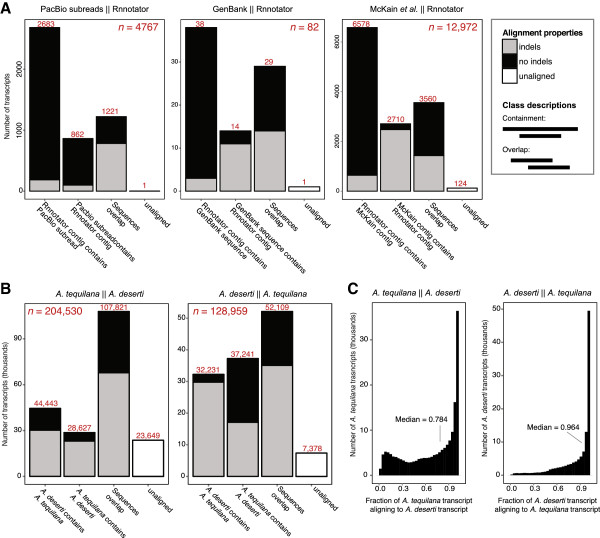
Comparison of the A. tequilana Rnnotator de novo assembly to additional datasets and to the A. deserti de novo assembly. (A) Comparison of the Agave tequilana Rnnotator assembly to Pacific Biosciences cDNA sequencing, A. tequilana sequences in GenBank, and an alternative de novo A. tequilana assembly built by McKain et al., 2012 [27]. See text for details. (B) Comparisons between the A. tequilana and A. deserti assemblies. Inset–key for alignment properties. Total number of sequences compared to A. tequilana Rnnotator contigs (n) is noted in each bar chart (n), and number of sequences in each alignment class is noted above bar. (C) Histograms of the fractional alignment lengths between A. deserti and A. tequilana. Symbol || delimits query dataset from subject dataset.